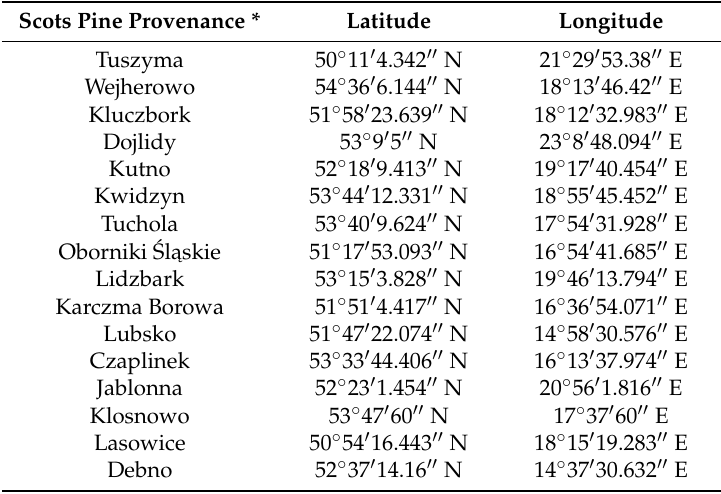
Table 2. Origin of Polish provenances of Pinus sylvestris used in the